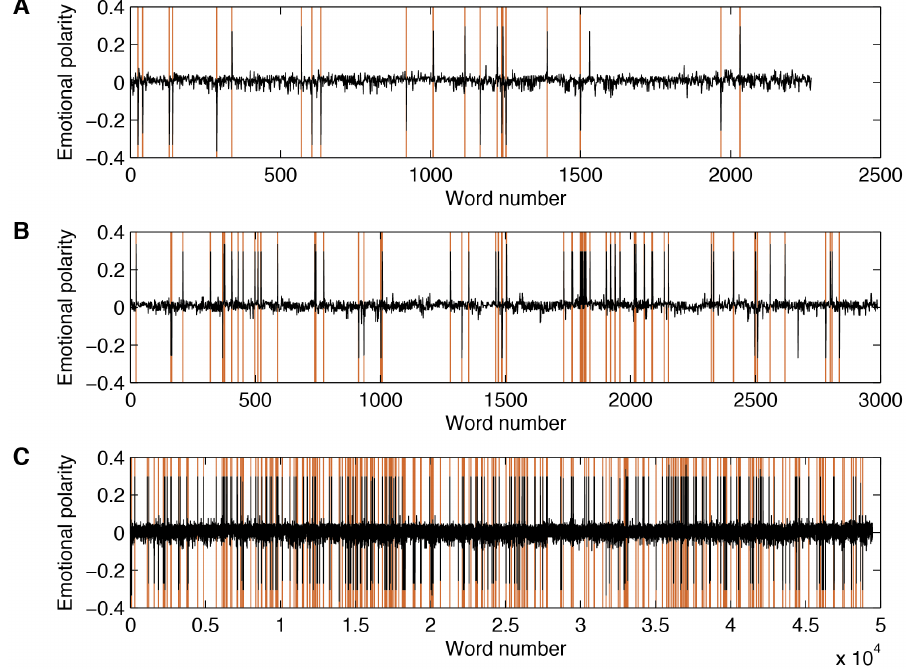
Figure 1. Data and transition points for (A) MAN, (B) HS, and (C) JUNG.